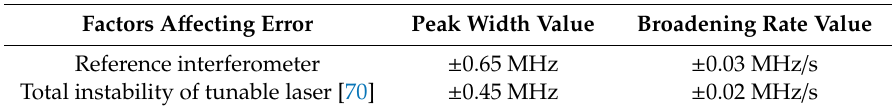
Table 1. Additional sources of